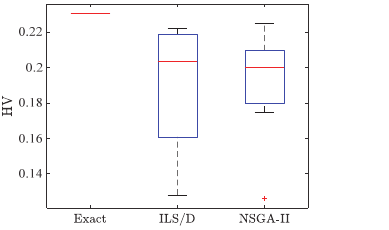
Fig. 3. HV boxplot for the exact, ILS/D and NSGA-II algorithms for the A- n37-k5 instance